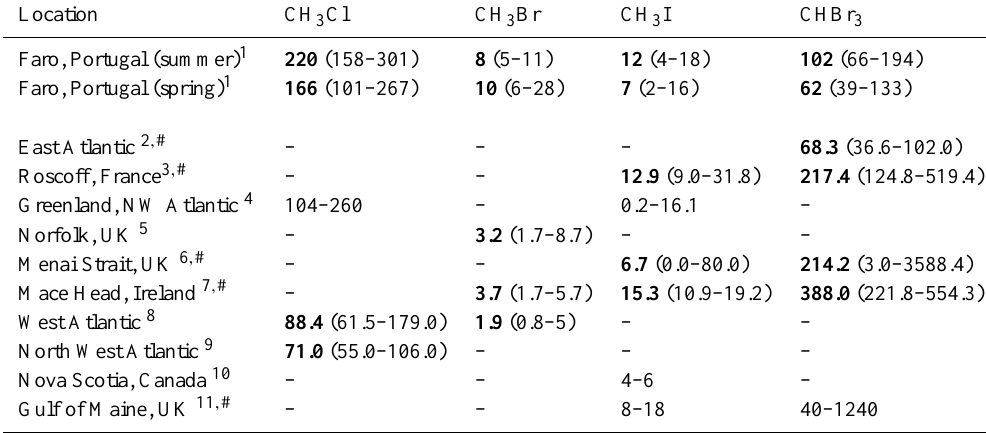
Table 5. Mean concentrations (bold) and ranges of dissolved halocarbons (pmolL − 1 ) from the subtropical lagoon Ria Formosa in summer 2011 ( n = 9) and spring 2012 ( n = 10) in comparison to published data from coastal Atlantic